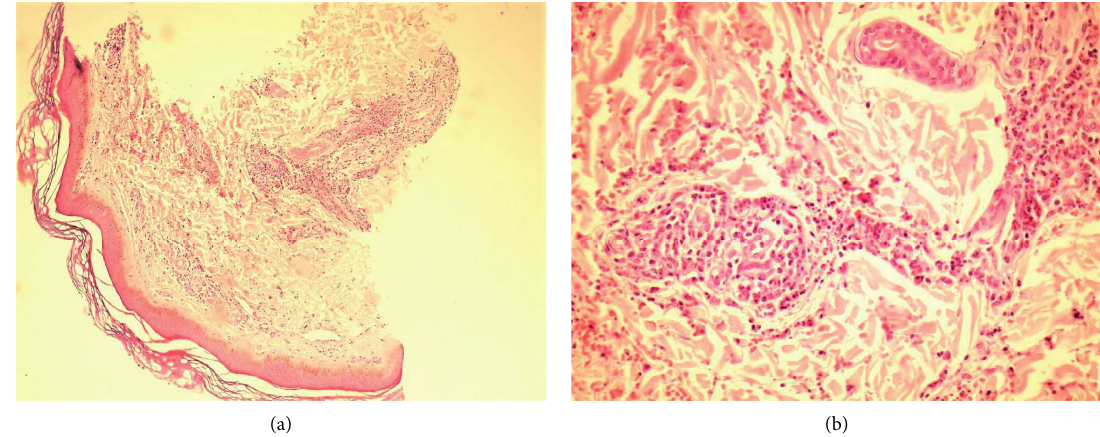
Figure 2: Perivascular neutrophilic infiltration, impinging vessel walls, RBC extravasation, and nuclear dust with endothelial cell plumping in the dermis (hematoxylin and eosin, 40x and 100x magnification,